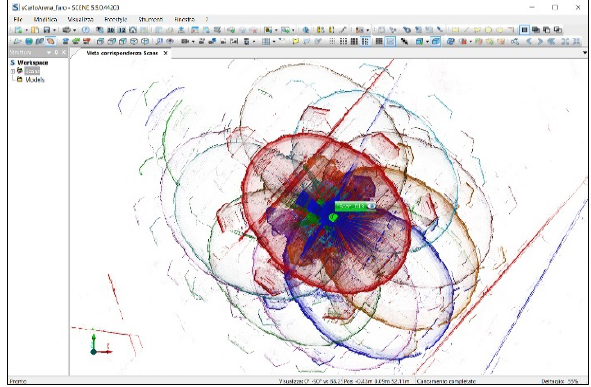
Figure 1. Point cloud in Faro